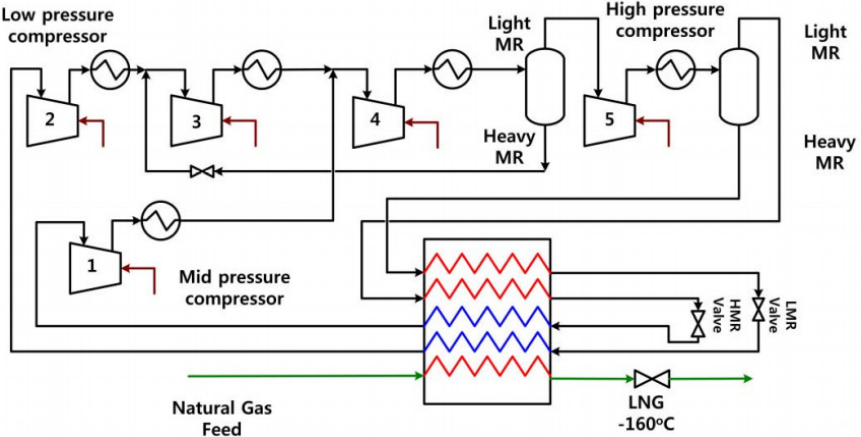
Figure 35. Process flow diagram KSMR cycle [128]. Reproduced with permission from Elsevier (license number